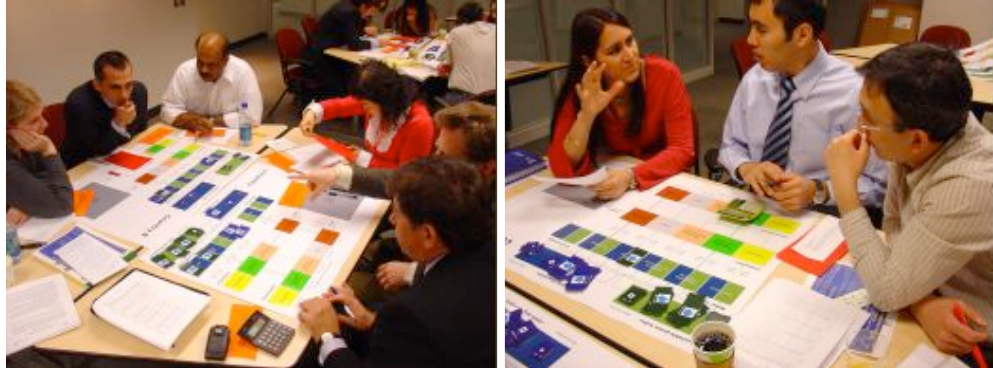
Fig. 2. Playing the Globalization of Water Role Play.